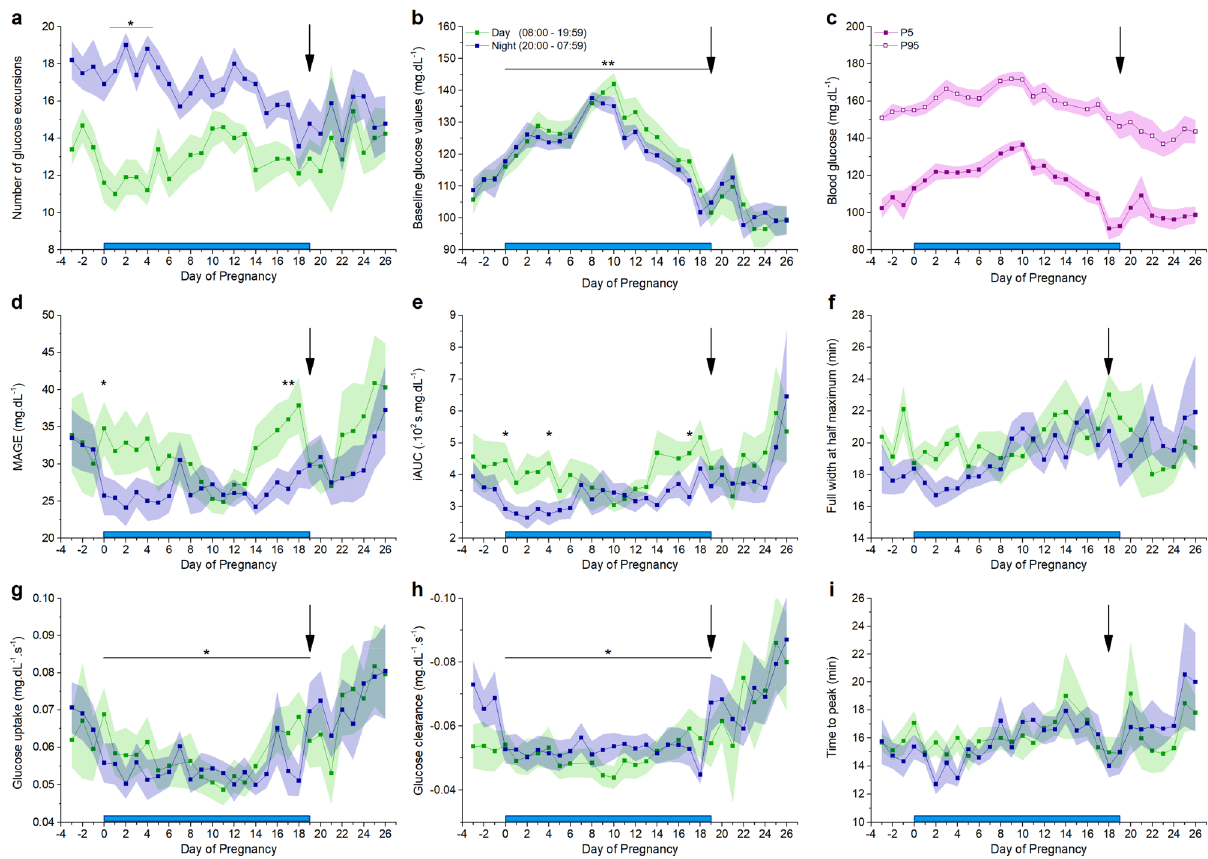
Figure 6. Characterization of glucose excursions. Blue bar: pregnancy. Black arrow: delivery. ( a ) Mean number of blood glucose excursions ± s.e.m., note the difference between the number of excursions during the day or the night decreases during the pregnancy. See also supplementary Fig. S3b. ( b ) Arithmetic mean of the baseline glucose values ± s.e.m., note the higher glucose values during the pregnancy (paired t-test) ( c ) Mean 5th and 95th percentiles ± s.e.m. over 24 h. See also supplementary Fig. S3c, note that the variance is higher in the 5th percentile. ( d ) Mean amplitude ± s.e.m. of glucose excursions (MAGE) (paired t-test corrected for multiple comparison). ( e ) Arithmetic mean incremental area under the curve (iAUC) ± s.e.m. of the glucose excursions (paired t-test corrected for multiple comparison). ( f ) Arithmetic mean full width at half maximum (FWHM) ± s.e.m. of the glucose excursions. ( g ) Arithmetic mean glucose uptake ± s.e.m. of the glucose excursions. The glucose uptake is slower during the pregnancy (paired t-test). ( h ) The arithmetic mean clearance rate ± s.e.m. of the glucose excursions is slower during the pregnancy (paired t-test). ( i ) Arithmetic mean time to peak of the glucose excursions. (n = 10 mice) See also supplementary Fig. S3b,c and pregnancy. We can show a distinct pattern of glucose excursions during day and night, from which parameters of individual glucose excursions as well as an overall view of glycaemia can be derived, including during delivery. The AUC of the OGTT increases during pregnancy and is at its lowest before and after pregnancy. Unlike the tail prick method, telemetric recording allows determination of the slope of glucose increase and clearance during an OGTT, as well as full width at half maximum and the amplitude of the maximal glucose increase. These values remain stable during pregnancy. In the course of pregnancy, the mean glucose levels rise until E10 and subsequently decrease towards the end. Interestingly, this pattern can be correlated with the change in gene expression of pancreatic islets and their proliferation, while they adapt to pregnancy 14 . In particular, from E9.5 on, the expression of Mki67 mRNA significantly increases which results in beta cell expansion. From E10 to the end of pregnancy, mean glucose decreases and by E17 they reach the same level as before pregnancy. Of note, subcutaneous body temperature remains relatively stable during pregnancy but increases (+ 0.5 °C) post-partum and remains increased up to five days post-partum. The activity shows a clear circadian rhythm, but nocturnal activity decreases throughout pregnancy. There is a remarkably higher activity the day following delivery. CGM in combination with video surveillance allows correlating individual glucose excursions with eating behaviour. The number of eating events is obviously different between day and night. Interestingly, the increase in mean glucose values towards E10 does not result from more time spent eating. The amount of time that mice were eating during the day (26.8% at E3, 29.4% at E11 and 28.5% at E18) is used as a proxy for the quantification of the amount of food consumed, and is in line with previous reports 15 . Thus time spent eating is an adequate measure of the amount of ingested calories. Typically, eating episodes are associated with large post-prandial glucose excursions. Interestingly, a significant number of glucose excursions could not be correlated to food